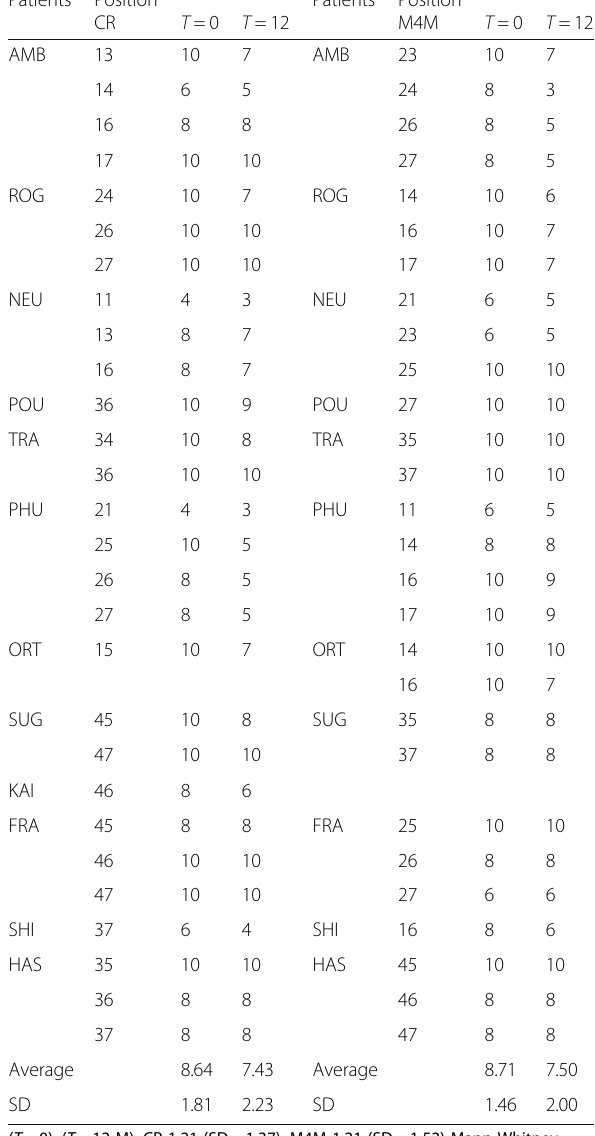
Table 2 Aesthetical Outcomes at T = 12 M (VAS Score) Patients Position CR